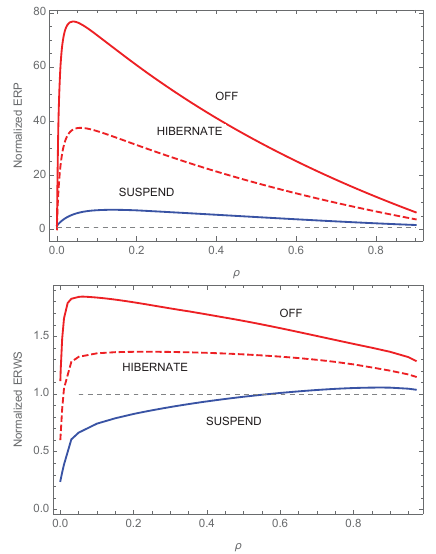
Figure 2: ERP and ERWS of the sleeping policies as a function of system load, normalized with respect